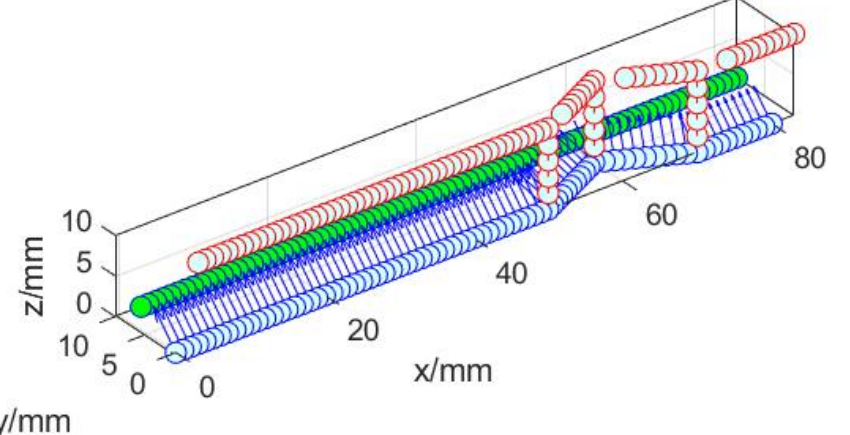
Figure 15. Model of the weld feature points and welding-torch angle. The red point is the feature point on sheet A, the green point is the feature point on sheet B, the light blue point is the weld feature point, and the dark blue arrow is the direction vector of the weld feature point pointing to axis Z of the sixth axis of the manipulator.